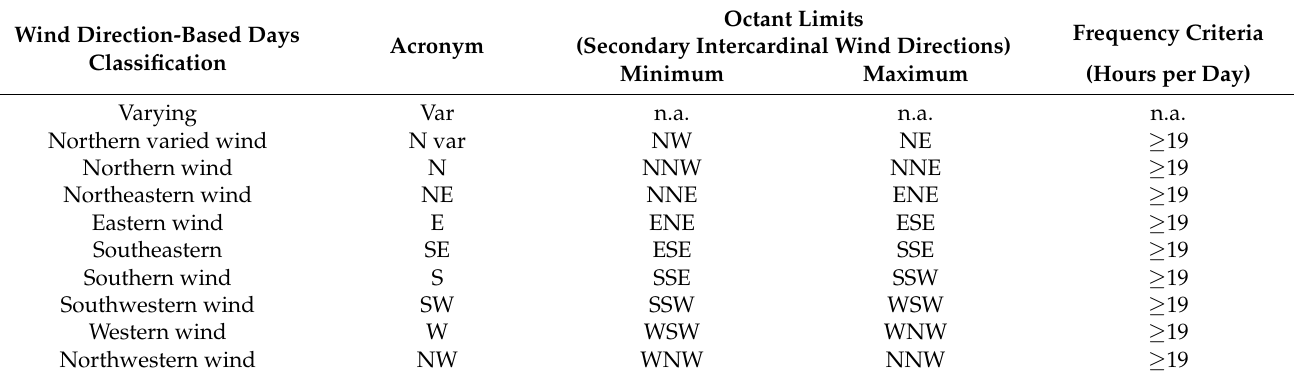
Table 2. Regional near-surface wind direction-based